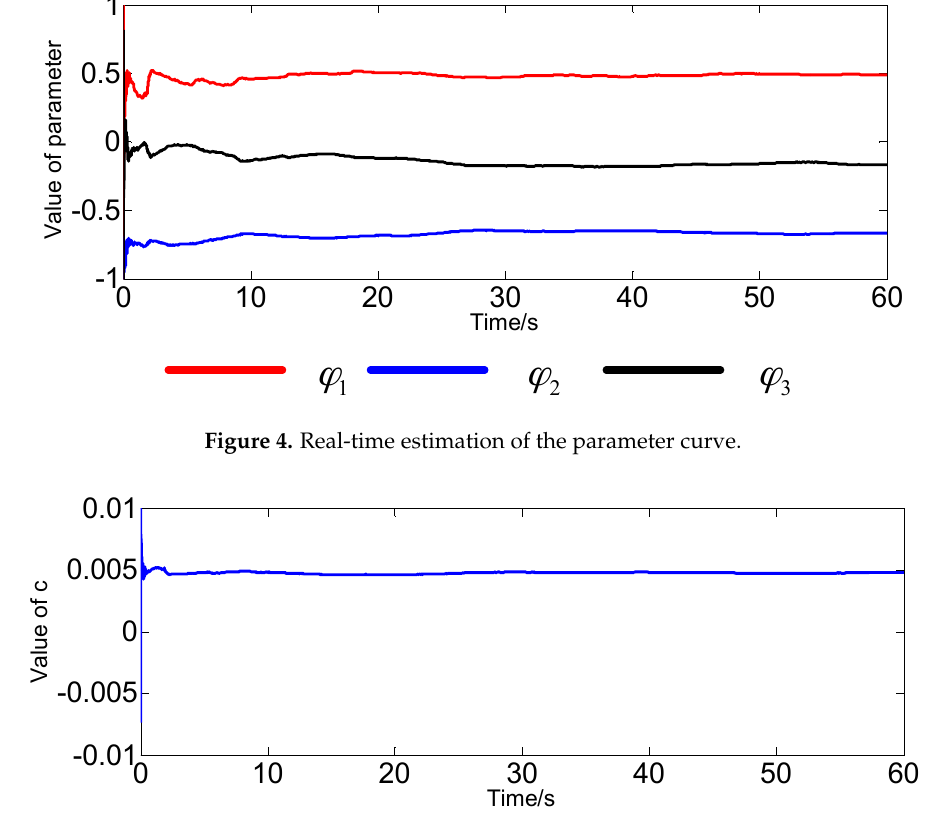
Figure 5. Real-time estimation of constant c.